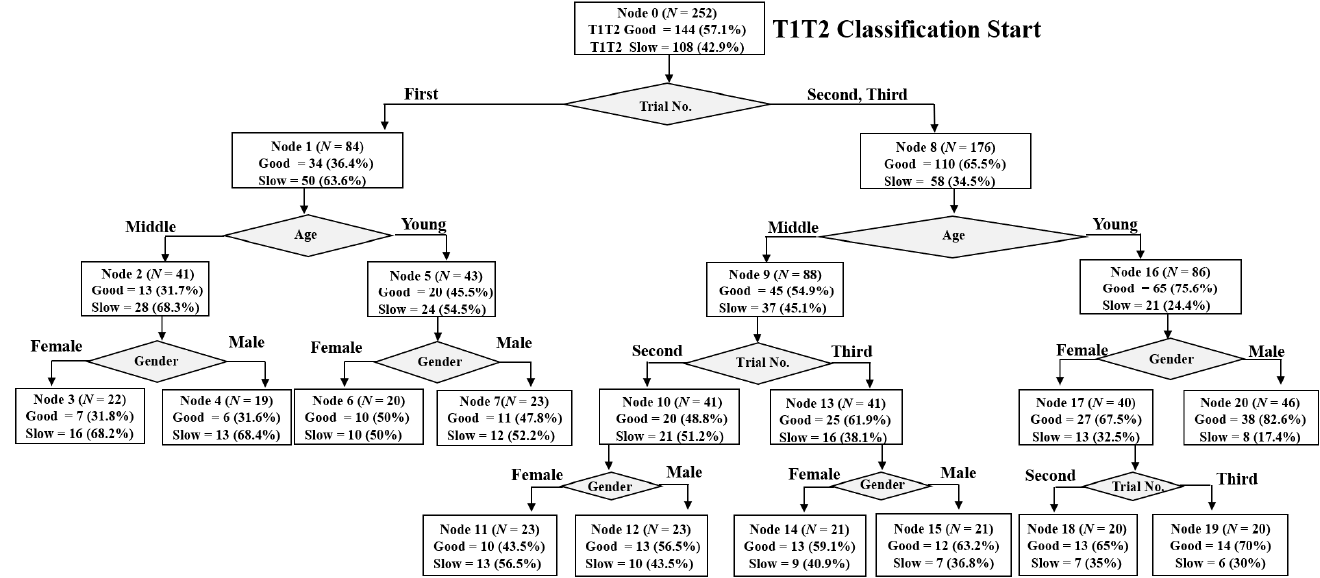
Figure 5. CART (classification and regression tree) decision tree for T1T2.